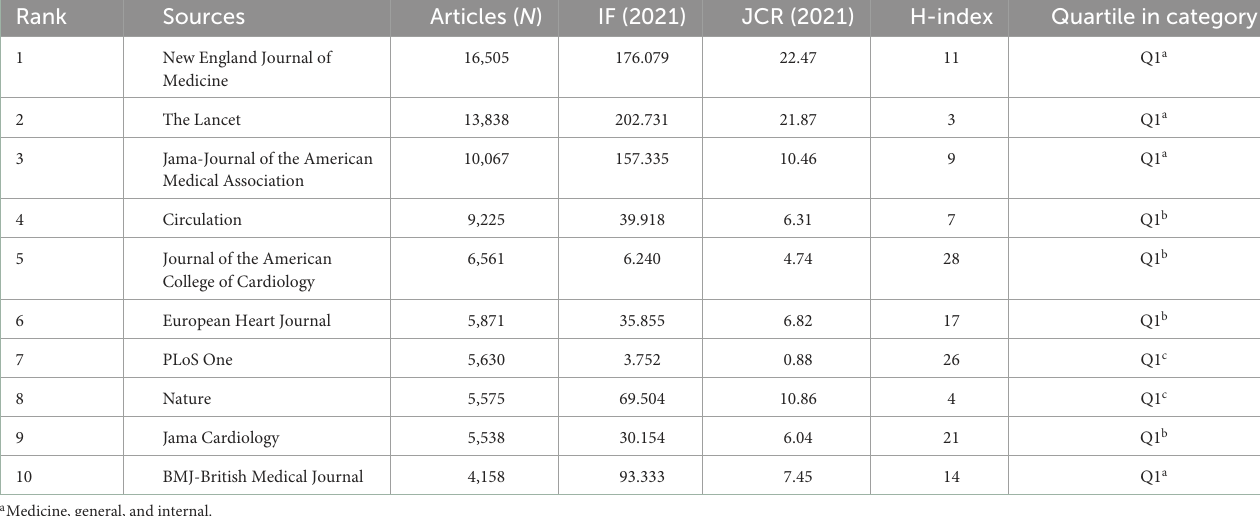
TABLE 4 Top 10 most productive co-cited journals related to CVDs and COVID-19. Rank